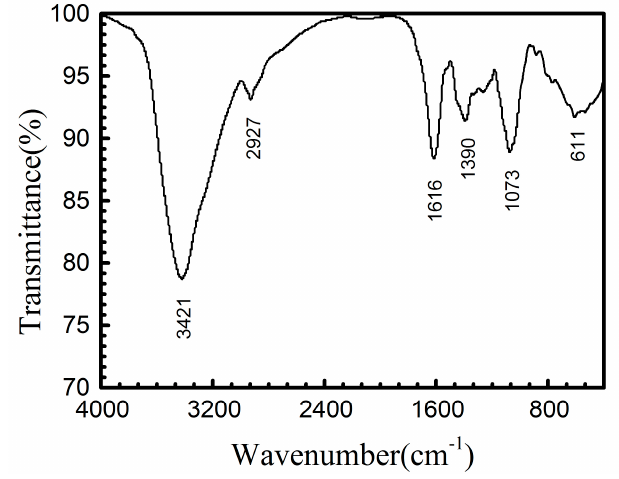
Figure 8. Fourier transform infrared spectroscopy (FT-IR) spectra of Eriobotrya japonica Thunb. leaf extract (EJTLE).